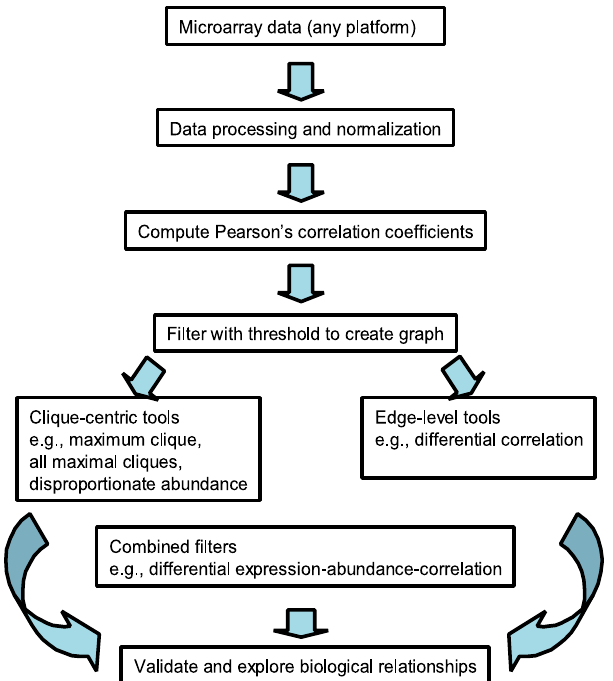
Figure 8. Overall Schema of Our Approach DOI: